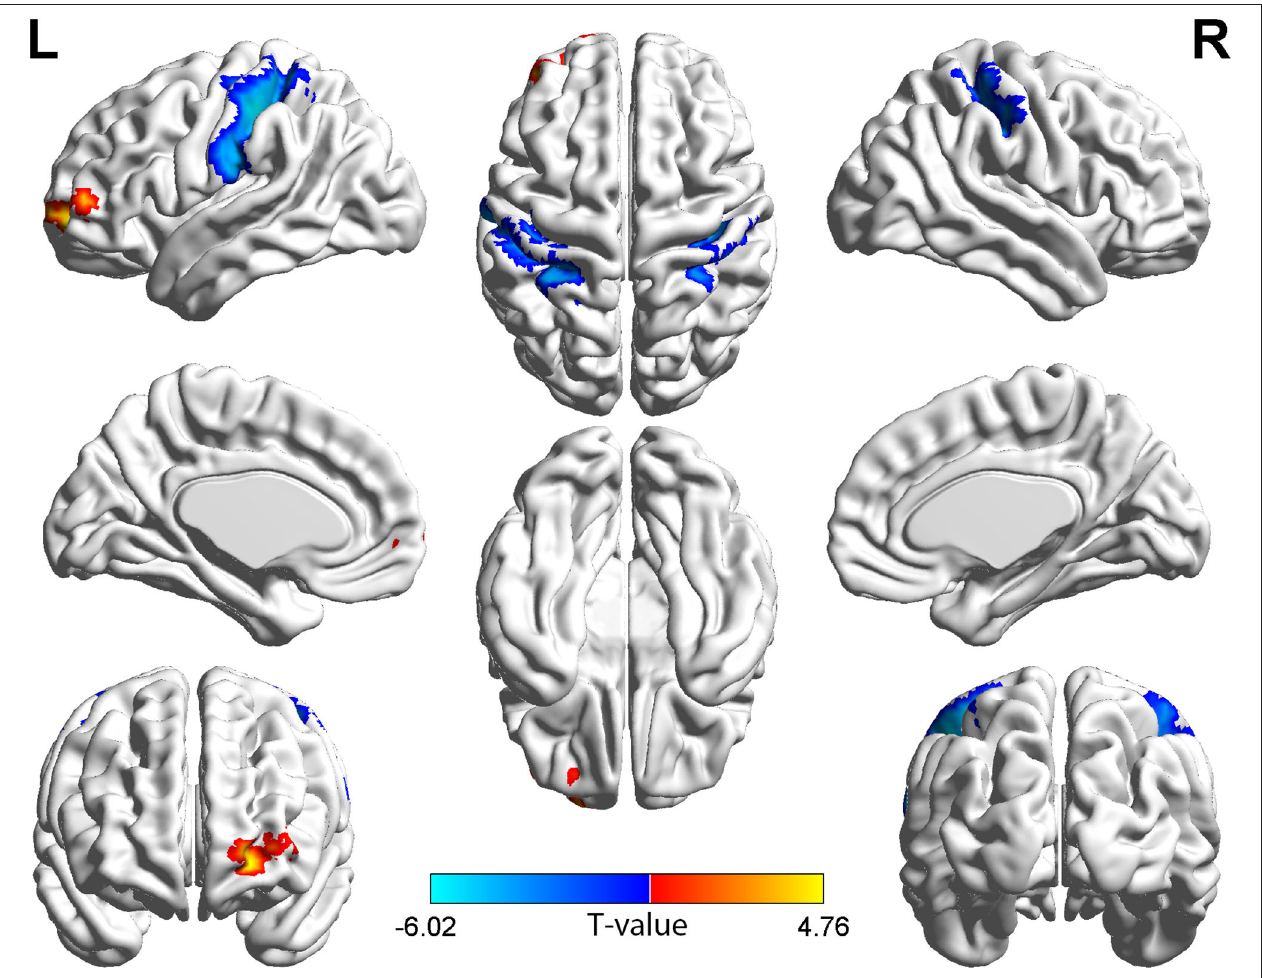
FIGURE 2 | Brain regions with long-range FCD difference between the group with TAO and HCs. Compared with HCs, the group with TAO showed significantly increased long-range FCD in the left MFG, ORBsup, and SFGdor, and significantly decreased long-range FCD in the bilateral PoCG, left SPG, and IPL (voxel p < 0.001, cluster p < 0.05, cluster-level FWE corrected, cluster size ≥ 114 voxels). The color bar indicates the T value from two-sample t- tests between the group with TAO and HCs, the warm color denotes relatively higher long-range FCD in the group with TAO, and the cold color denotes relatively lower long-range FCD in